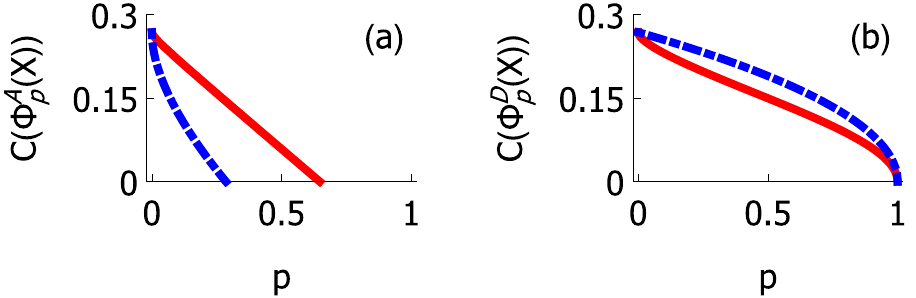
Figure 6. Concurrence of a state as a function of the channel strength parameter p for ( a ) amplitude damping and ( b ) depolarizing channel. Here the red and blue curves correspond to the cases with local noise on qubit U and L , respectively. We have chosen ρ ρ ρ = . = = . 0 9, 0,